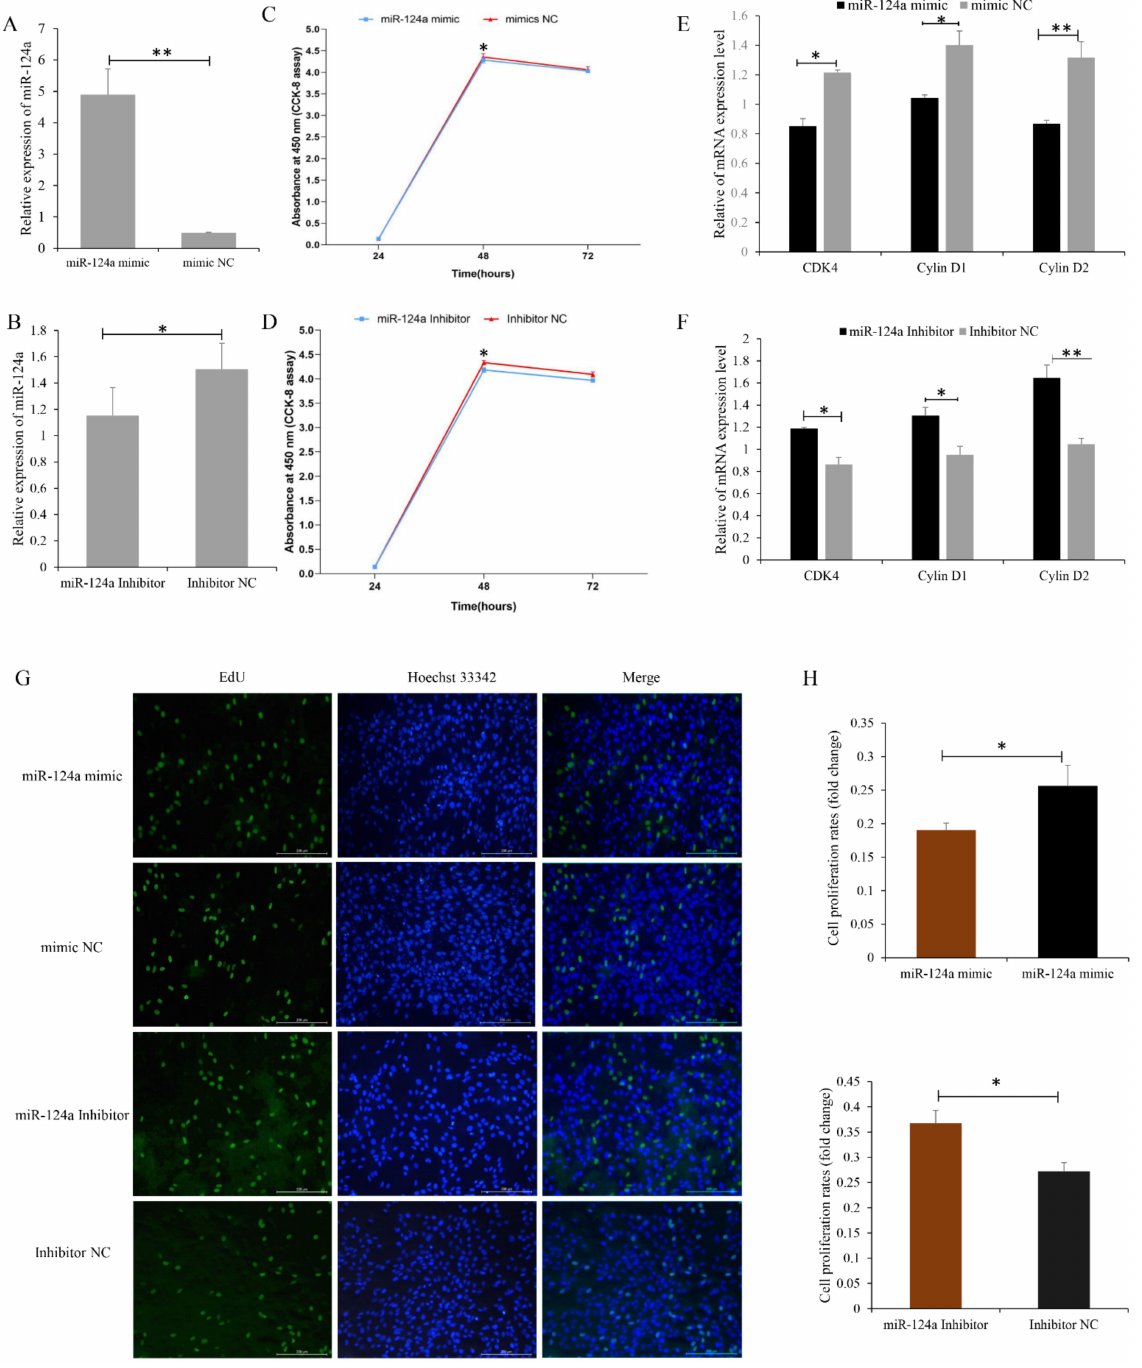
Figure 6. miR-124a regulates the proliferation of goat myoblasts: ( A , B ) RT-qPCR was used to determine miR-124a expression levels in myoblasts transfected with the miR-124a mimic and inhibitor. ( C ) Proliferation curve of myoblasts overexpressing miR-124a. ( D ) Proliferation curve of myoblasts underexpressing miR-124a. ( E ) Expression of the proliferation-related genes CDK4, cyclin D1, and cyclin D2 in cells overexpressing miR-124a. ( F ) Expression of proliferation-related genes in cells underexpressing miR-124a. ( G ) Myoblasts overexpressing and underexpressing miR-124a stained with EdU. ( H ) Fold change in the proliferation of myoblasts overexpressing and underexpressing miR-124a. Replicates = 3. Data are shown as the mean ± SE. * p < 0.05 and ** p < 0.01. NC, negative